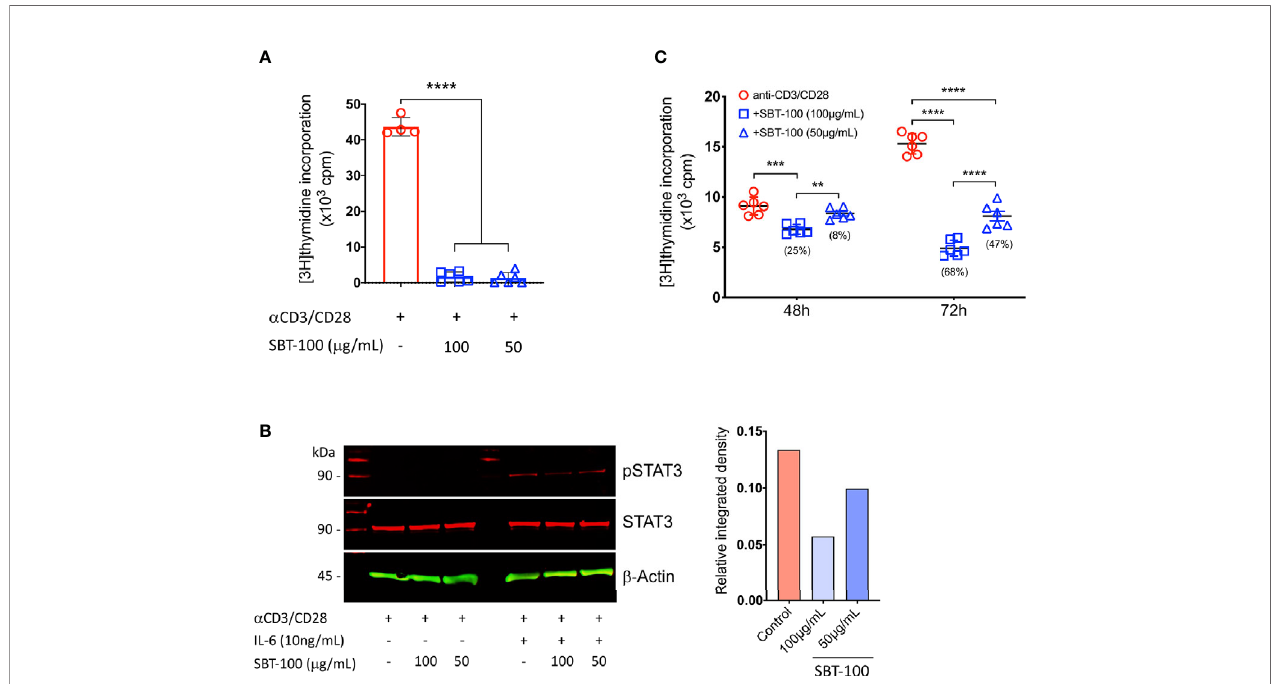
FIGURE 1 | SBT-100 inhibits lymphocyte and STAT3 activation. (A) Sorted mouse primary naïve CD4 + T cells were stimulated with anti-CD3/CD28 in medium containing SBT-100 and on Day 3 T cell proliferation was assessed by [3H]-thymidine incorporation assay. (B) Cells stimulated for 48 h were removed, washed, and starved for 2 h in serum-free medium containing 0.5% BSA and then stimulated for 30 min with IL-6 at 10 ng/ml. Whole cell lysates from the cells were analyzed by Western blotting and pSTAT3 levels were normalized to total b -actin and quanti fi ed using Image-J software. (C) Human Jurkat T cells were stimulated for 48 h or 72 h with anti-CD3/CD28 in medium containing SBT-100 and on Day 3 T cell proliferation was assessed by [3H]-thymidine incorporation assay. Data represent at least three independent experiments and presented as mean ± SEM. (** p < 0.01; *** p < 0.001; **** p <